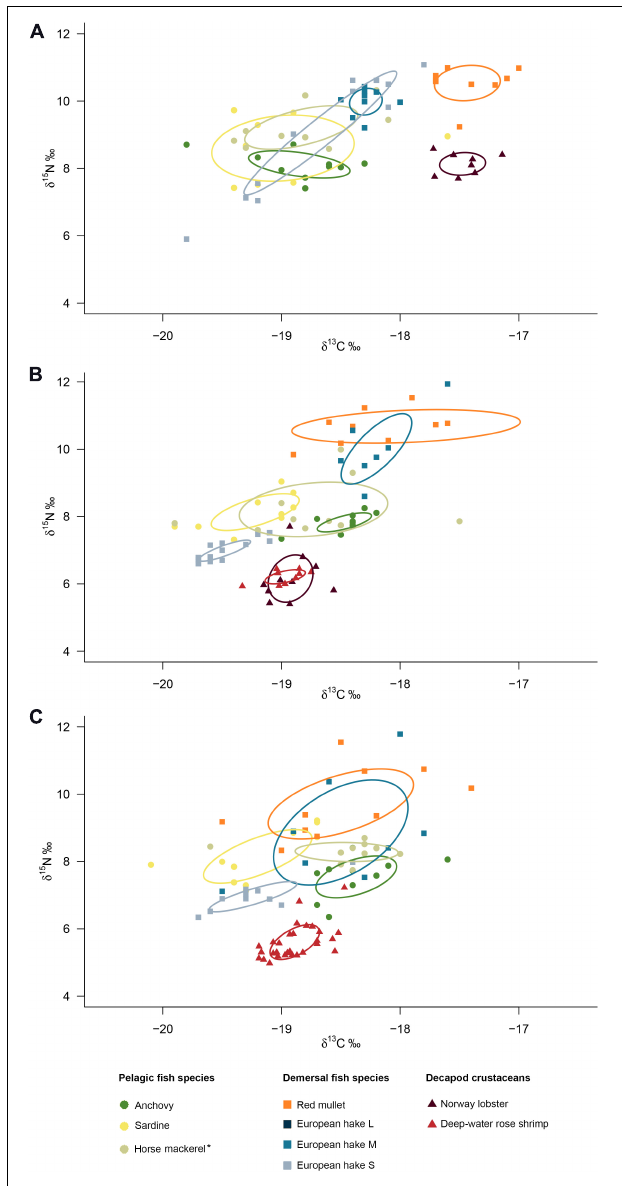
FIGURE 4 | Variation in δ 13 C and δ 15 N, SEA c and isotopic niche overlap of the fish and crustacean species examined in the (A) Northern, (B) Middle and (C) Southern areas of the Croatian part of the Adriatic Sea. *Mediterranean horse mackerel in the Northern and Middle areas and Atlantic horse mackerel in the Southern